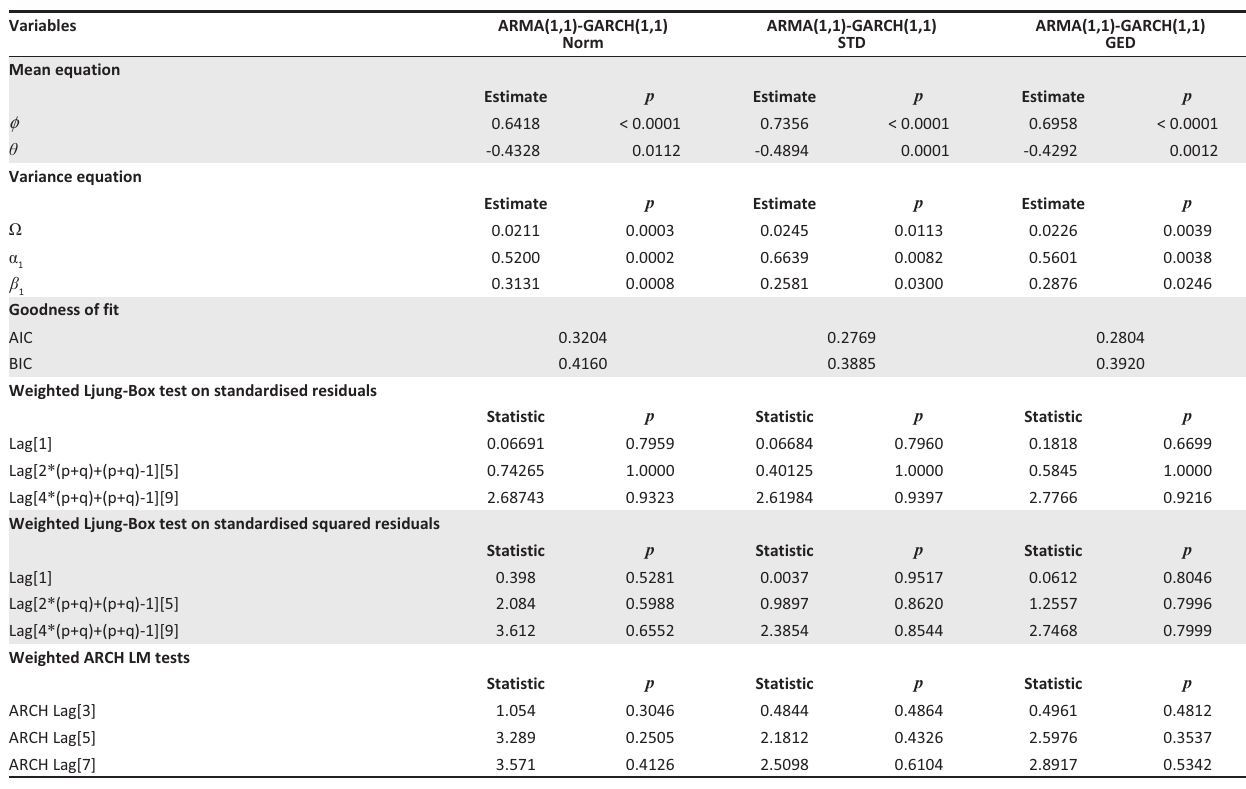
ARMA, autoregressive moving average; GARCH, generalised autoregressive conditional heteroscedasticity; GED, generalised error distribution; ARCH, autoregressive conditional heteroscedasticity; LM, Lagrange Multiplier. FIGURE 3: ARMA(1,1)-GARCH(1,1) model